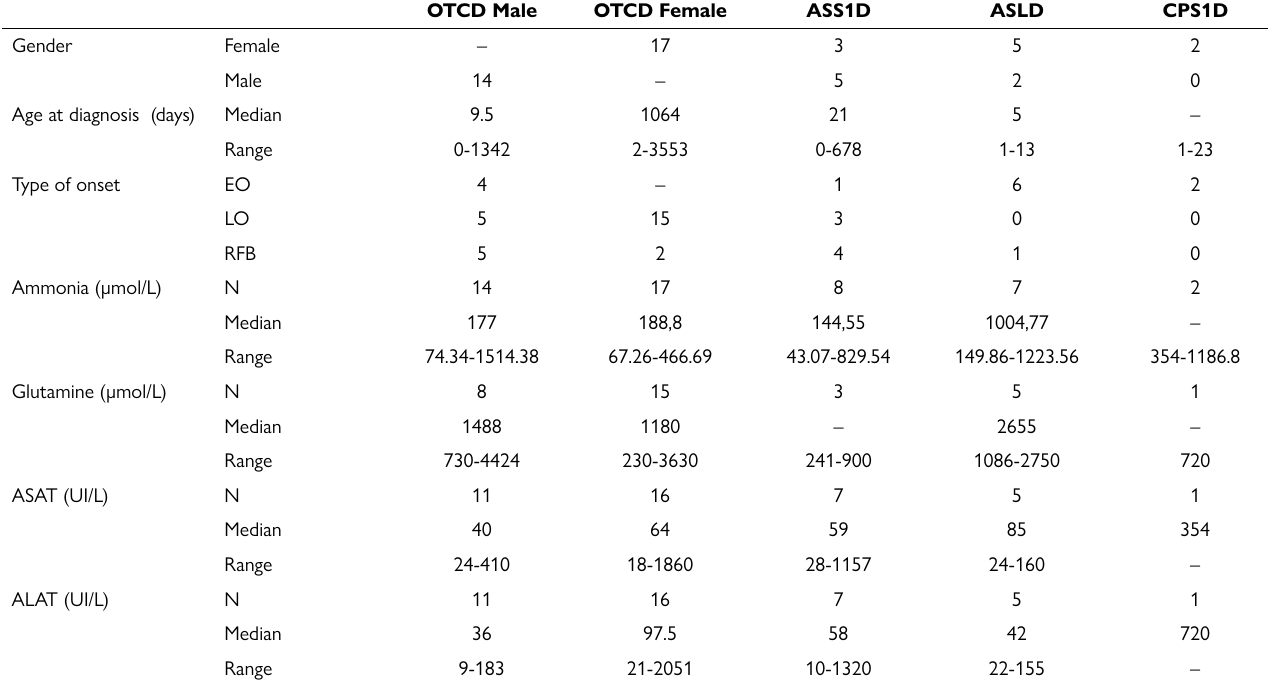
Table 1. UCDs patients and biochemical